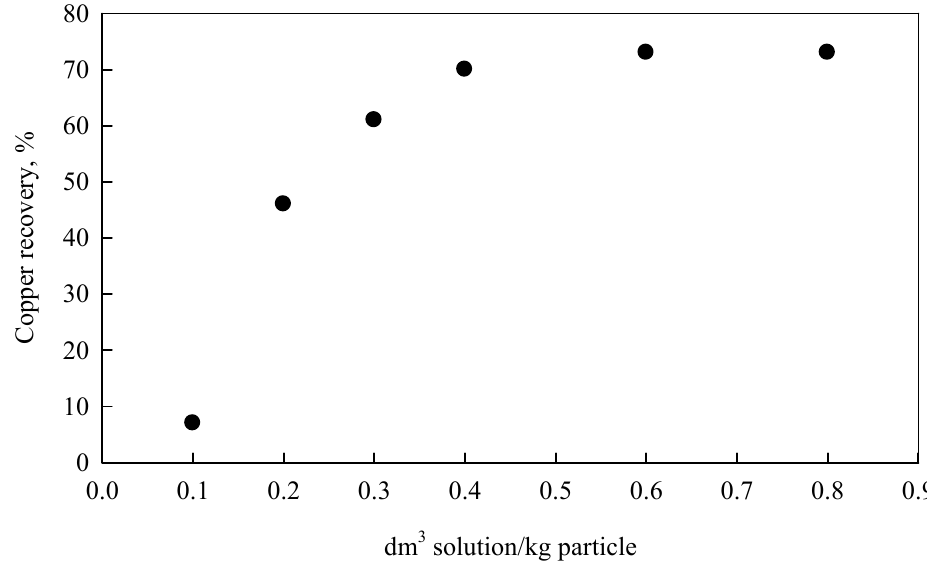
Figure 10. Evaluation of the effect of the solid/liquid ratio on copper recovery. Working conditions: NH 4 OH = 0.1 mol/dm 3 , temperature = 298 K, particle size = 5 μ m, pH = 10.5, stirring rate = 500 rpm and experiment time = 3600 s.